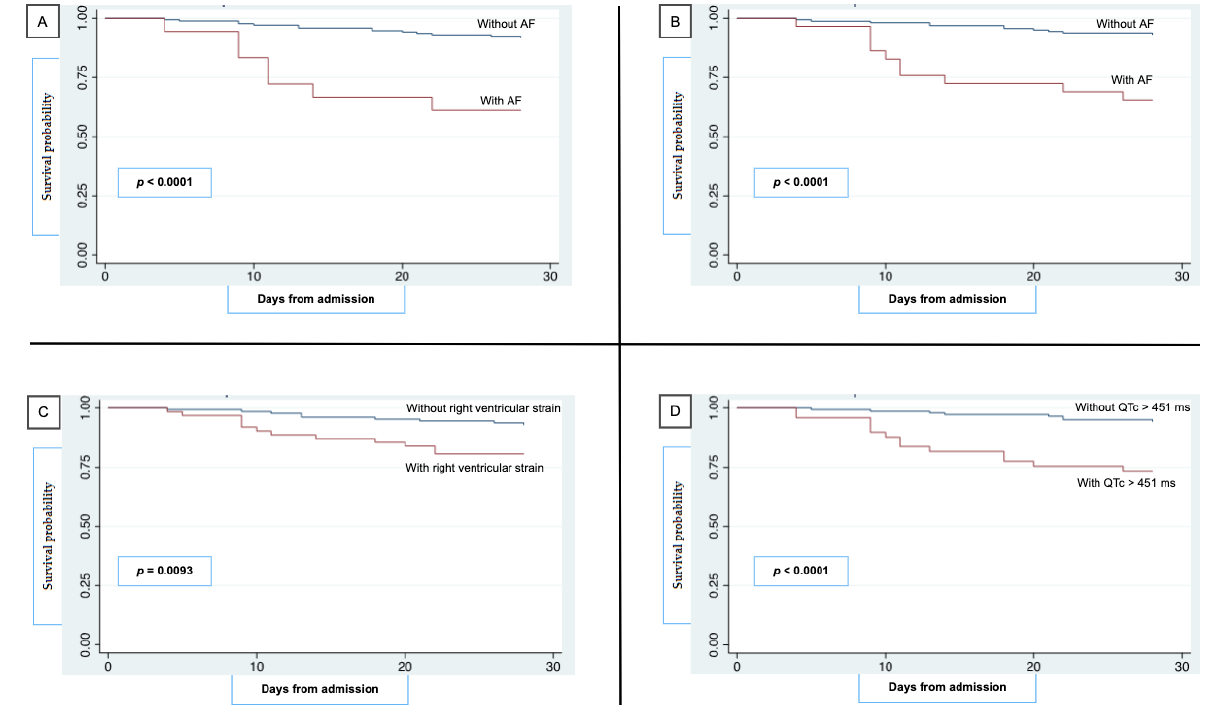
Figure 3. Estimated 28-day survival probability after hospital admission for patients with and without AF rhythm detection on ED presentation ( A ), on ED presentation and with in-hospital onset ( B ), right ventricular strain ( C ), and prolonged QTc interval ( D ). ED, emergency department; AF, atrial fibrillation.